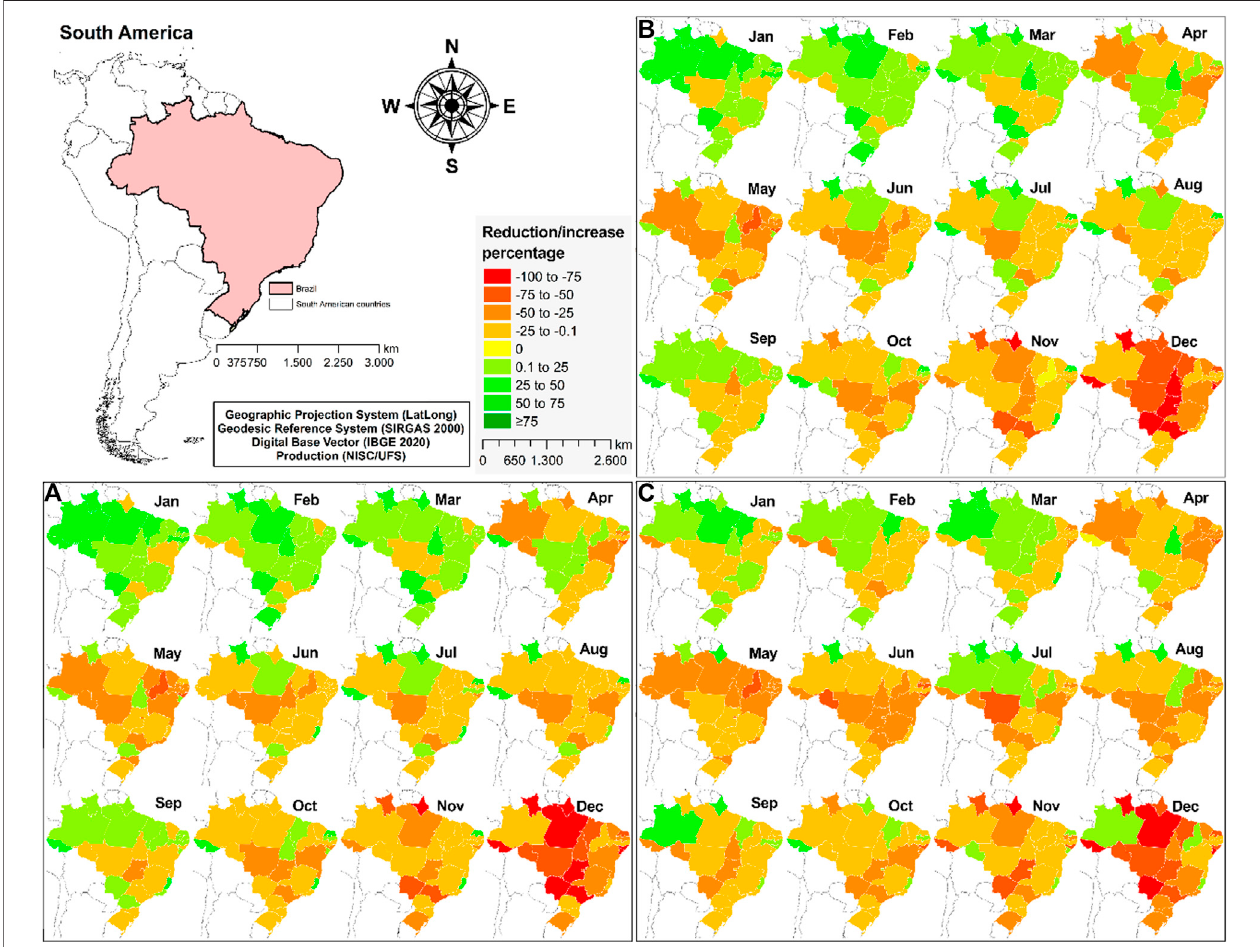
FIGURE3| SpatialdistributionofthemonthlypercentageofchangeintheTBcasesinBrazil,betweenJanuaryandDecember2020: (A) Newcasesoftuberculosis (TB); (B) New cases of pulmonary tuberculosis (PTB); (C) Baciloscopy-positive (AARB+) cases.